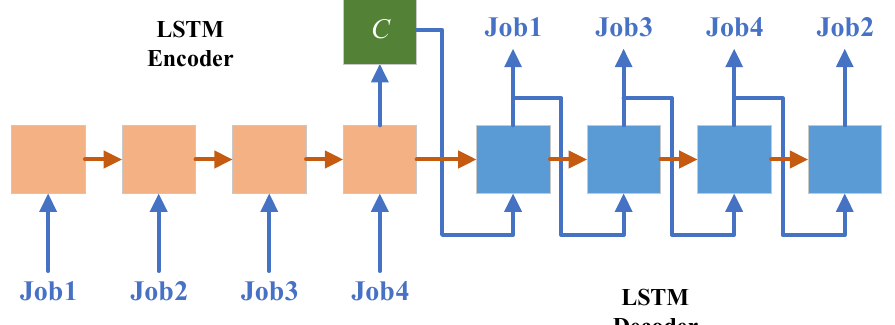
Figure 2. The sequence-to-sequence network structure.